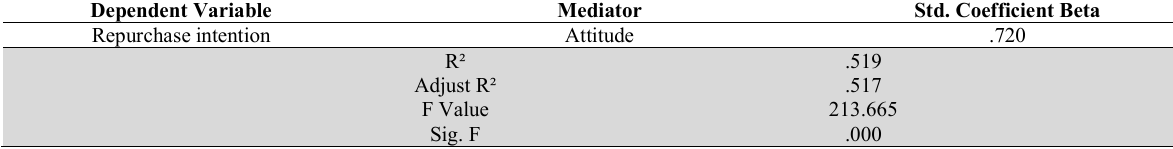
Regression Analysis (Mediator to Dependent